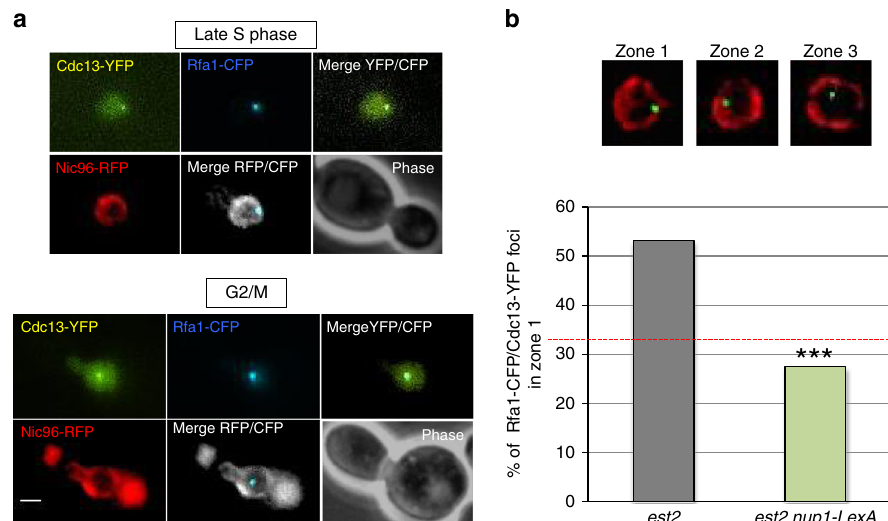
Fig. 2 Nup1-LexA alters the localization of damaged telomeres during senescence. a Damaged telomeres were detected as foci containing both Cdc13- YFP and Rfa1-CFP and localized relative to Nic96-RFP that marks the nuclear periphery. Representative images of late S (upper panel) and G2/M (lower panel) cells are shown. Scale bar: 2 μ m. b The localization of the Cdc13-YFP/Rfa1-CFP foci in the three zones of equal area of the nucleus marked by Nic96- RFP (upper panel) was scored in late S and G2/M cells. Cells were imaged after one restreak from spore colonies (about 35 PDs from the initial spores). The percentages of zone 1 foci are from analysis of two independently isolated est2 Δ ( n = 96 cells) and est2 Δ nup1-LexA ( n = 120 cells) clones. The analysis of the repartition of Rfa1/Cdc13 foci between the three equal zones of the nucleus is shown for individual clones in Supplementary Fig. 2a. Statistical differences were determined by a Fisher ’ s exact test (*** p =